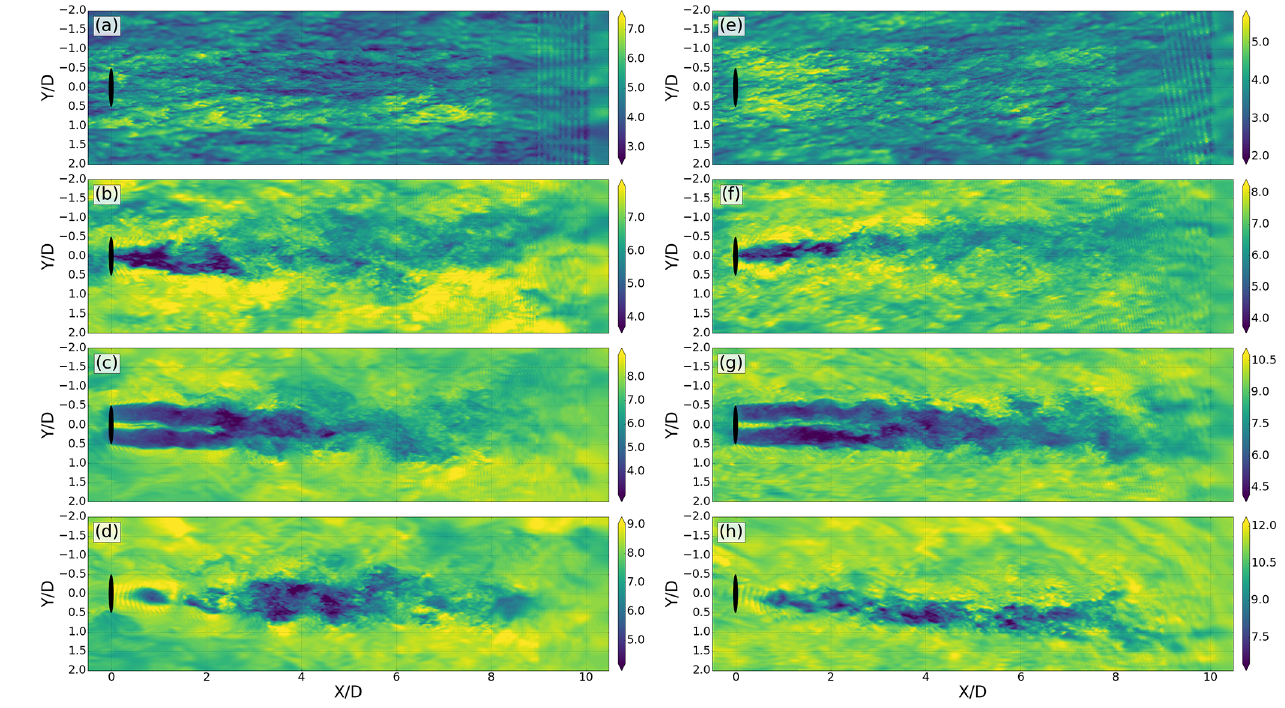
Figure 3. Contoured horizontal cross sections of horizontal wind speeds (ms − 1 ) comparing the neutral (a–d) and stable (e–h) cases at the near surface (1m; a , e ), rotor bottom (40m; b , f ), rotor center (80m; c , g ), and rotor top (120m; d , h